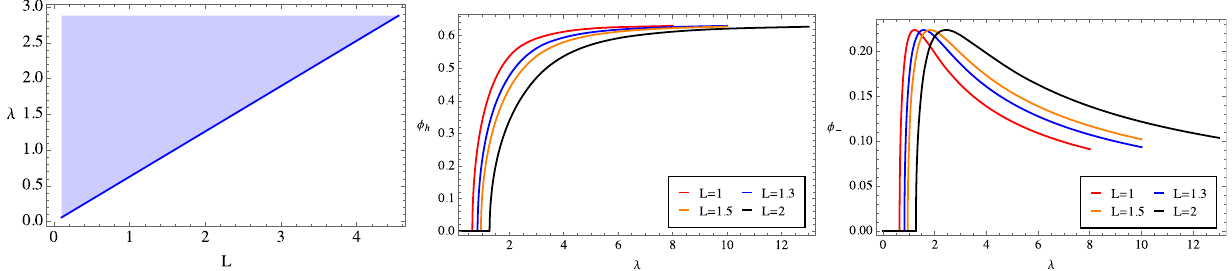
Fig. 8 Left: the threshold curves for AdS black hole with zero curvature; Middle: the scalar hair near the horizon as the function of λ with different AdS radius L ; Right: the corresponding scalar charge of the black hole φ − as the function of λ